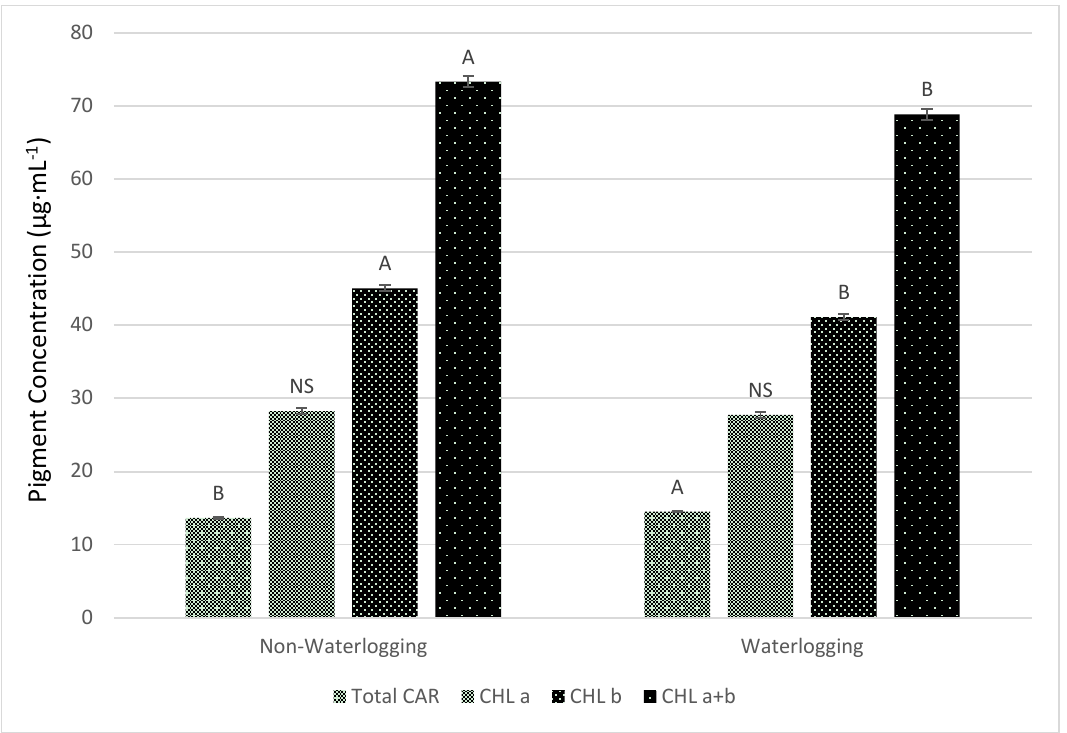
Figure 3. Total carotenoid (CAR), total chlorophyll (Chl a + b), chlorophyll a (Chl a), and chlorophyll b (Chl b) concentrations of cucumber plants under waterlogged or non-waterlogged conditions for 10 days. Plants were harvested and analyzed for CAR and Chl at the end of 10 days.